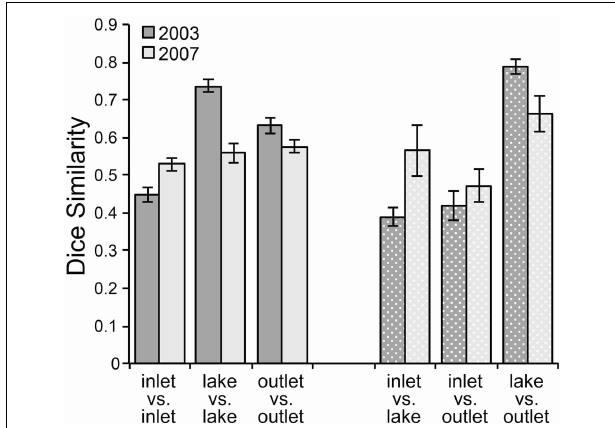
FIGURE 3 | Dice similarity of DGGE banding patterns at sites at Lake I-8 in summer 2003–2007. Error bars are standard error of the mean. Solid columns show average pair-wise similarity among communities at each site (inlet, lake, outlet) across sampling dates. Stippled columns show average pair-wise similarities between communities at different sites sampled on the same day. “Inlet” designates the I-8 inlet stream, “outlet” designates the outlet stream, and “lake” designates samples collected from the lake water column at the I-8 West station.